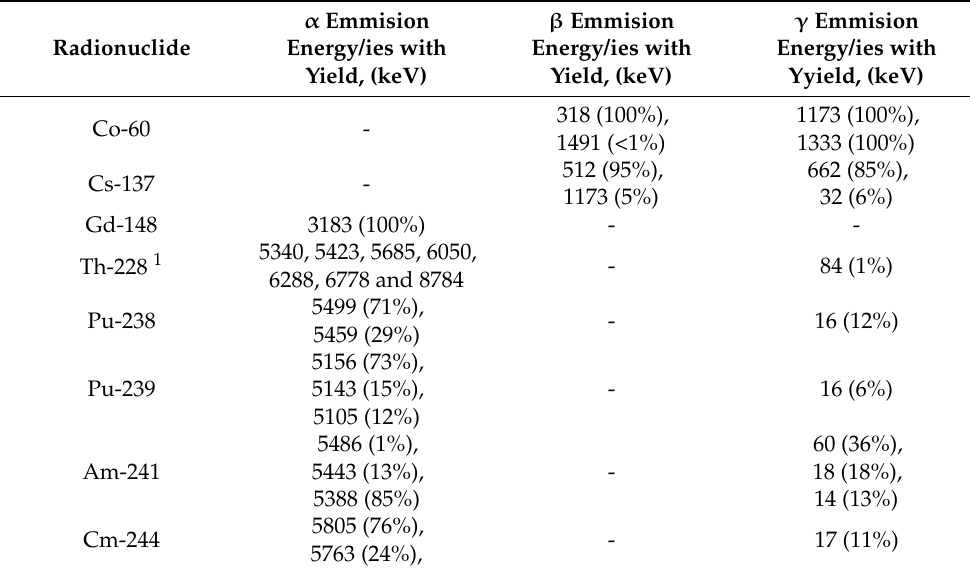
Table 3. Overview of radionuclides used in this paper with their main emission energies and yield per decay [30].